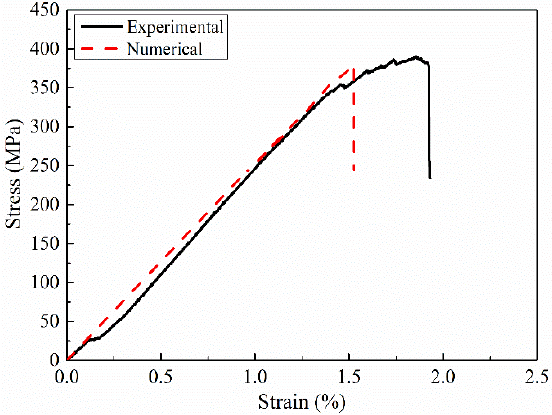
Figure 13. Comparison of GFRP laminates between simulation and experimental.